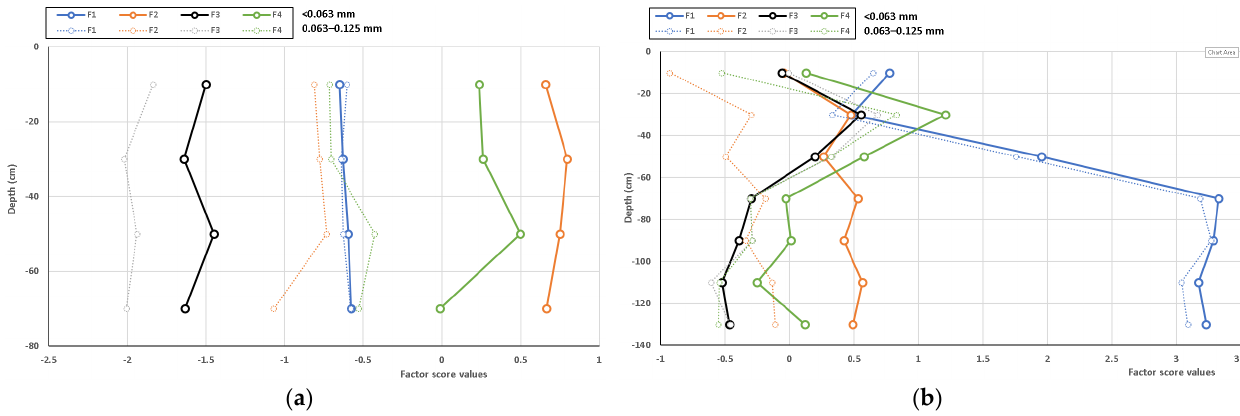
Figure 7. Factor score values in the profiles through alluvial sediments of the Voglajna river, above ( a ) and below ( b ) the main anthropogenic sources of elements.